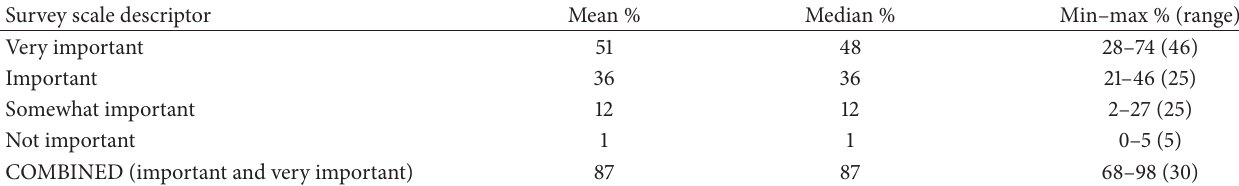
Table 3: Frequency (%) with which survey scale descriptors were used to rate 33 improvement topics (by 560 respondents).